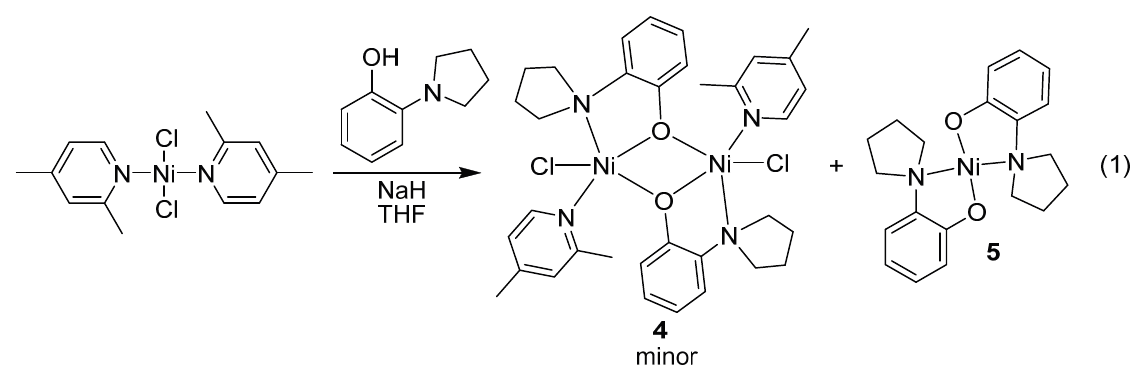
Scheme 2. Exploring the coordination chemistry of aminophenol